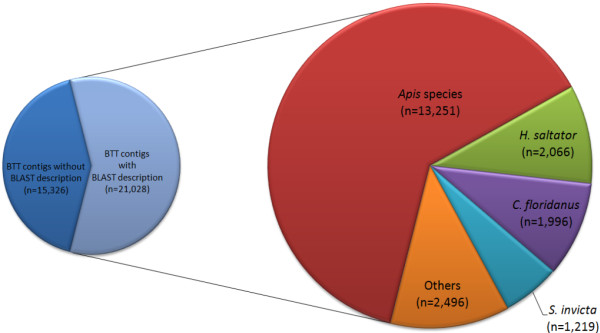
Pie-chart displaying the species distribution for top BLAST match for BT_transcriptome_v2 contig set against NCBI nr database. BLASTx, E-value cut-off of 1e-06, against NCBI nonredundant database generated putative matches for 21,028 B. terrestris sequences. Species generating the most putative matches were Hymenopteran insects: 13,251 (Apis species); 2,066 (C. floridanus); 1,996 (H. saltator); 1,219 (S. invicta); 608 (Nasonia species); and 410 (Bombus species). Others account for 1,478 putative BLAST matches for BT_transcriptome_v2 contigs.